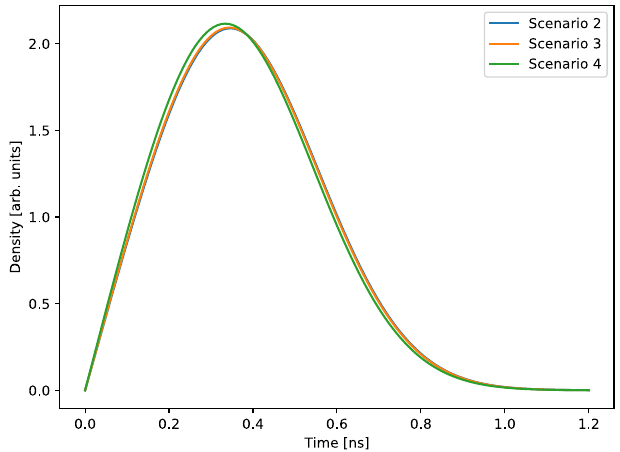
FIG. 12. Distribution of synchrotron amplitudes during LHC fill 7443, obtained by following different strategies.